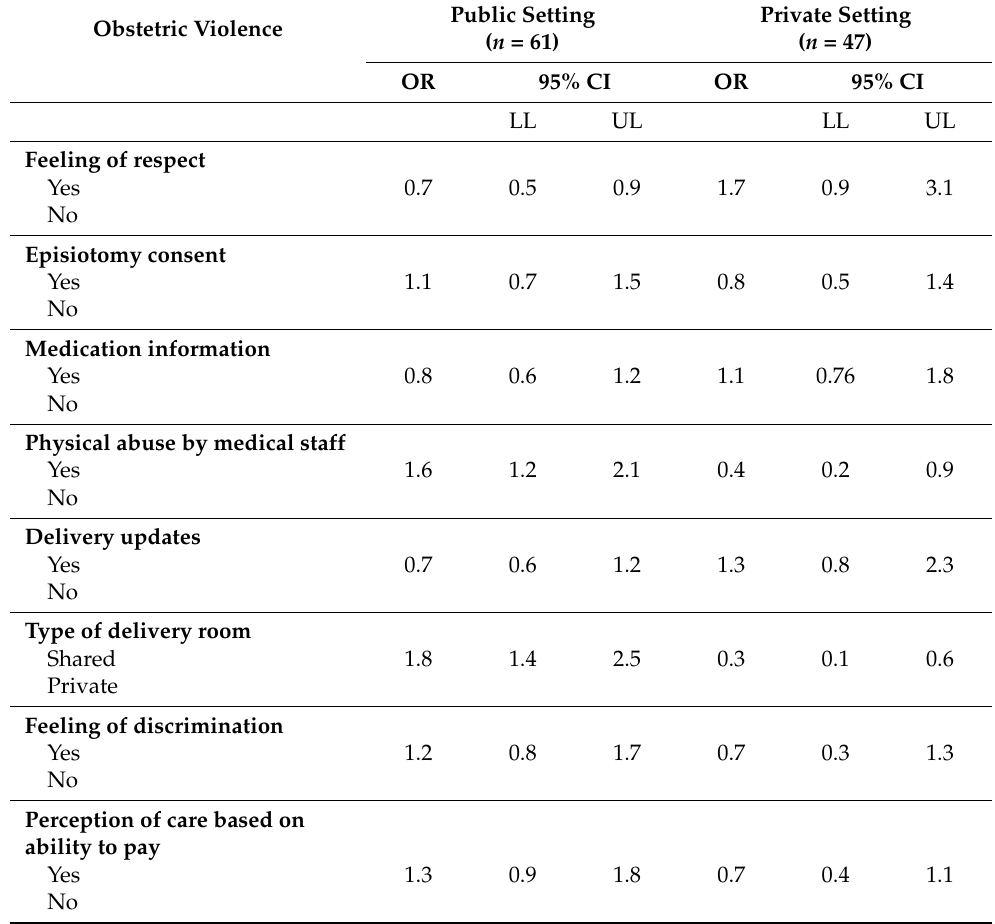
Table 3. Risk of obstetric violence domains in episiotomy cases ( n = 108) in public to private settings (Amman,